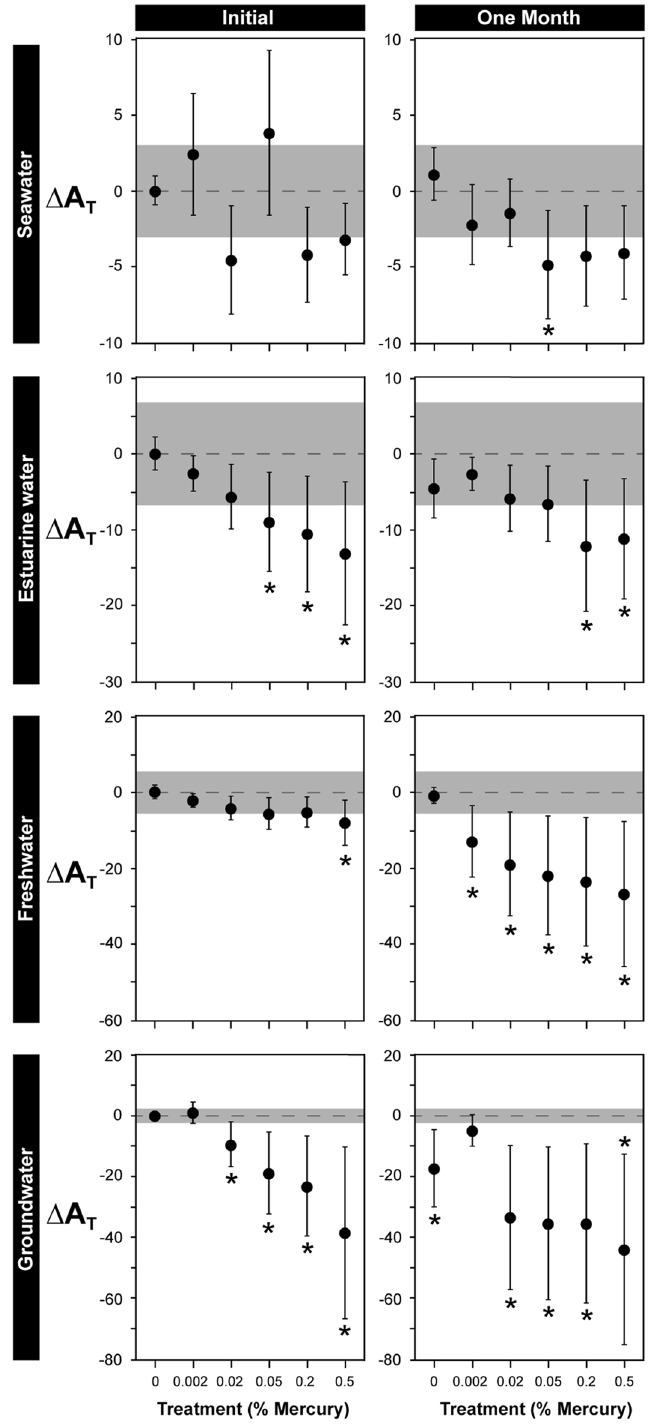
Figure 2. The effects of mercury concentration on total alkalinity (∆A T ) of seawater, estuarine water, freshwater, and groundwater samples stored for 0 or 1 months. Results represent the difference between observations and the mean A T of untreated samples measured at the beginning of the experiment (A T of benchmark controls are shown in Table 1). Shaded areas on graphs represent ± 2 standard deviations of the respective benchmark control (Table 1). Asterisks indicate there was a significant difference in A T of samples in a treatment compared to the A T of the benchmark control according to Dunnett’s tests, and should not be used to evaluate statistical difference or similarity among treatments. Data are means ± 1 standard deviation. n = 5 except for the freshwater 0.05% mercury/1 month treatment where n =